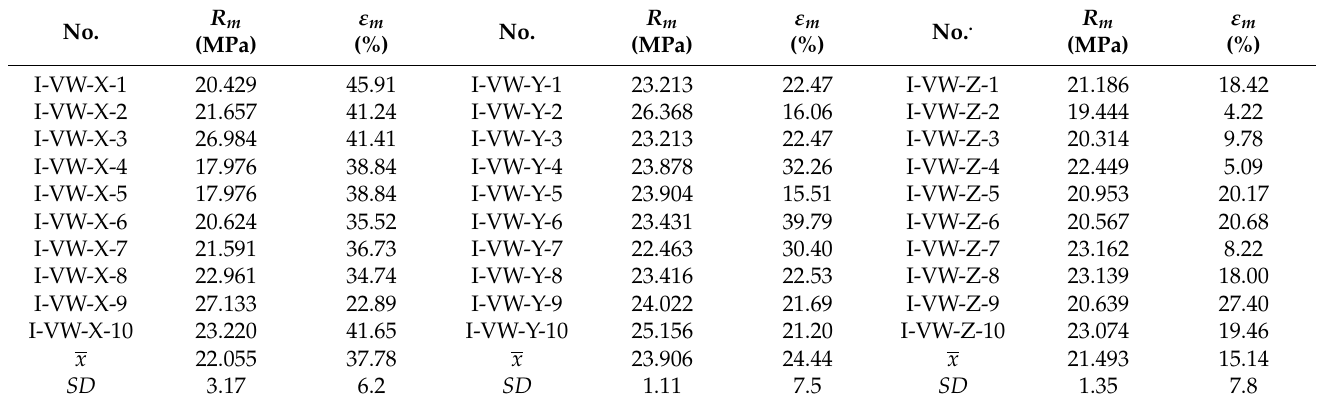
Table 2. Ultimate tensile strength and the maximum percentage strain for the VeroWhite specimens.